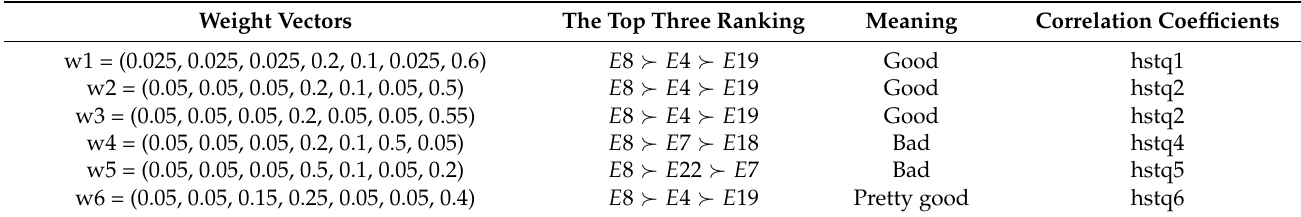
Table 5. The top five results with differences in weight vectors. Weight Vectors The Top Three Ranking Meaning Correlation Coefficients